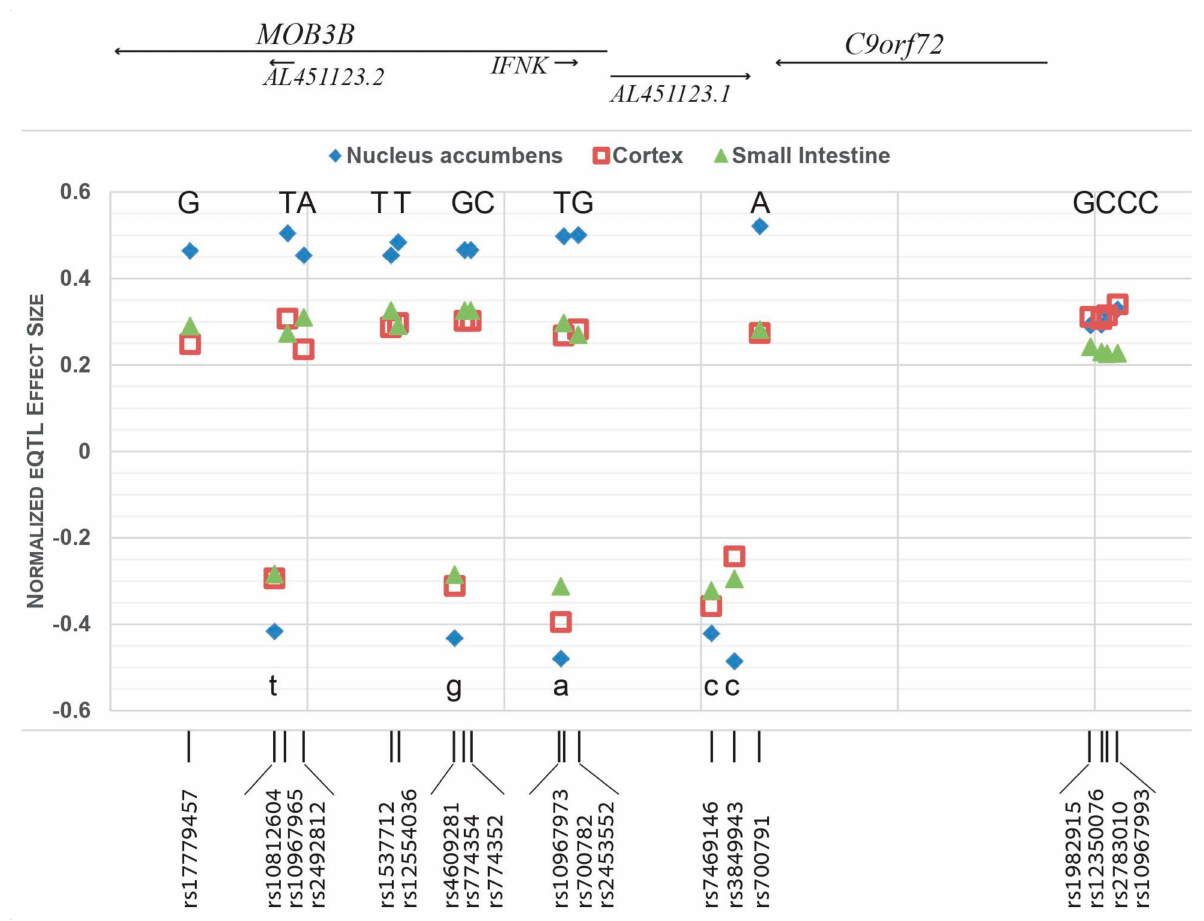
Figure 2. Higher levels of C9orf72 RNA expression for all 19 SNVs within the risk-haplotype: Normalized eQTL effect size in Nucleus accumbens (dimond), Cortex (square), and small intestine (triangle). Upper panel and upper-case letters are the alternate allele observed in the risk haplotype, associated with higher levels of C9orf72 expression; lower panel and lower-case letters are the reference allele observed in the risk haplotype, associated with higher levels of C9orf72